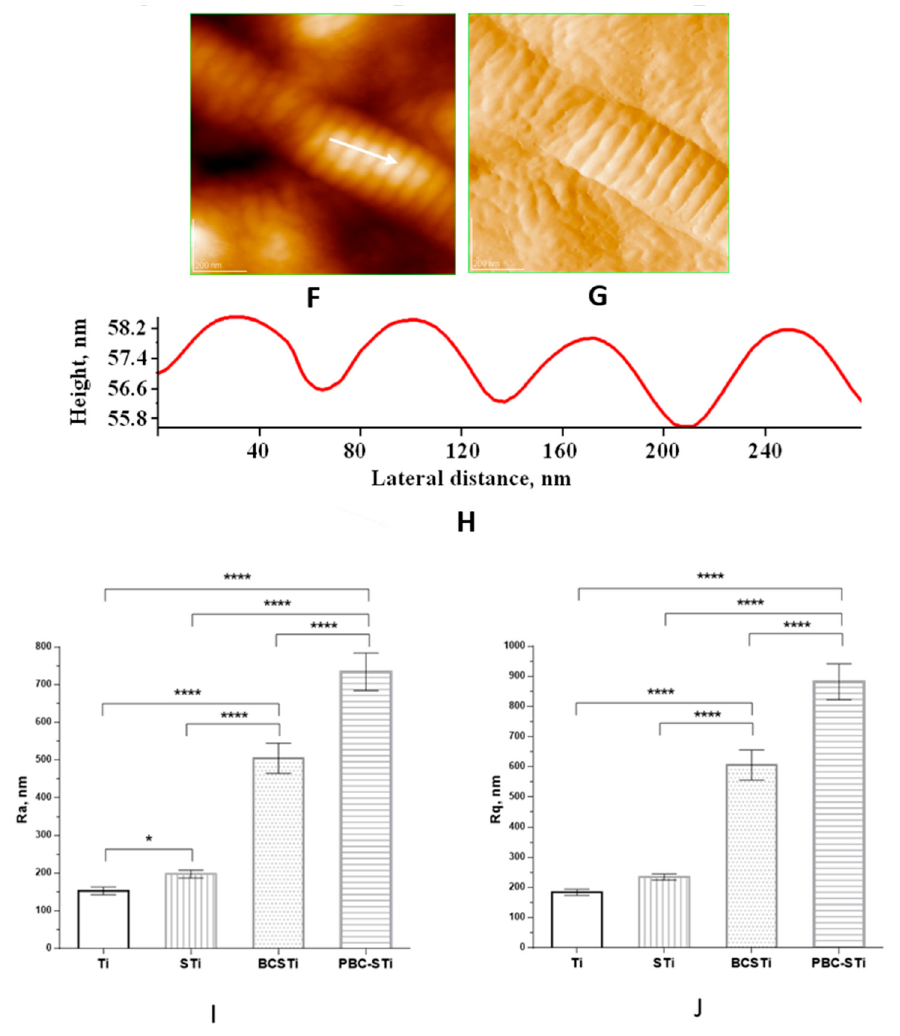
Figure 1. AFM images of the 2D topography of the modified surface of Ti implants via ( A ) grit blasting to create a Ti implant; ( B ) grit blasting and acid etching to create a standard (control; STi) implant. ( C ) The 2D topography and ( D ) amplitude image of a porous biomimetic composite (PBC) that was made of ms-HAP/COL@PLA and deposited on the surface of an STi implant, resulting in a PBC-STi implant; ( E ) SEM image of a biomimetic composite (BC) coating that was made of ms-HAP/COL@PLA/COL (having the outermost layer of self-assembled collagen (COL)), deposited on the surface of an STi implant, resulting in a BCSTi implant. ( F ) The 2D topography and ( G ) amplitude image of COL fibers that were adsorbed on a PBC (C,D) coating, resulting in a BCSTi implant ( E – G ); cross-section profile of a COL fiber ( H ) along the white arrow in panel ( F ), which illustrates the periodicity of the nanostructure of about 67 nm on the COL fiber. ( A – D ) scanned area of 20 µ m × 20 µ m; ( E ) scale bar of 30 µ m; ( F , G ) scanned area of 1 µ m × 1 µ m. Ra ( I ) and Rq ( J ), respectively, of the four modified Ti implants: the surface of Ti implant that was modified using grit blasting, noted as Ti, followed by acid etching, named STi, and then coated with porous biomimetic composite, noted as PBC-STi, or coated with biomimetic composite, noted as BCSTi; * statistically significant with p < 0.05; **** statistically significant with p < 0.0001. The surface roughness parameters Ra and Rq were found to be the following: Figure 1A— Ra = 153 ± 10 nm and Rq = 184 ± 10 nm for the Ti implant, Figure 1B—Ra = 198 ± 10 nm and Rq = 235 ± 10 nm for the STi implant, Figure 1C—Ra = 734 ± 50 nm and Rq = 882 ± 60 nm for the PBC-STi implant and Figure 1E—Ra = 505 ± 40 nm and Rq = 606 ± 50 nm for the BCSTi implant. The thickness (height) of the biomimetic coating was about 1500 ± 60 nm;